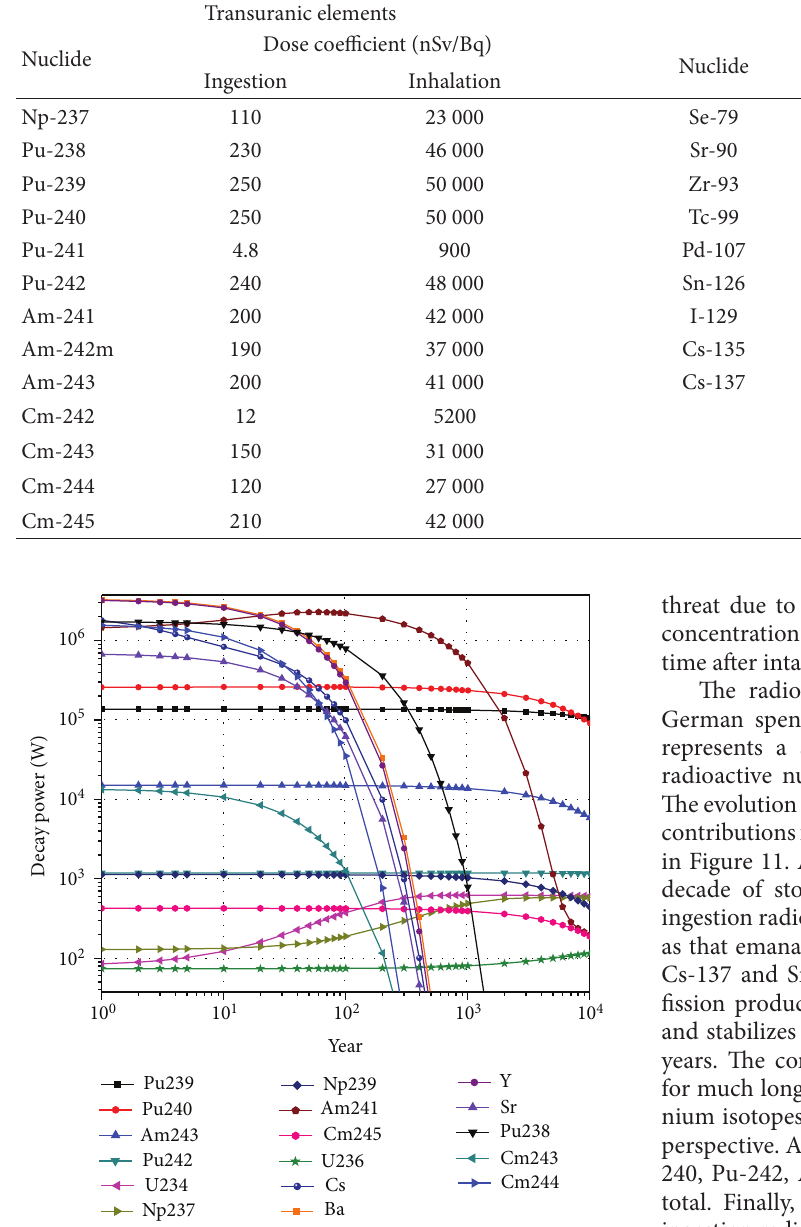
F 10: Major contributors to decay power generated by stored SNF in the time period from 1 to 10,000